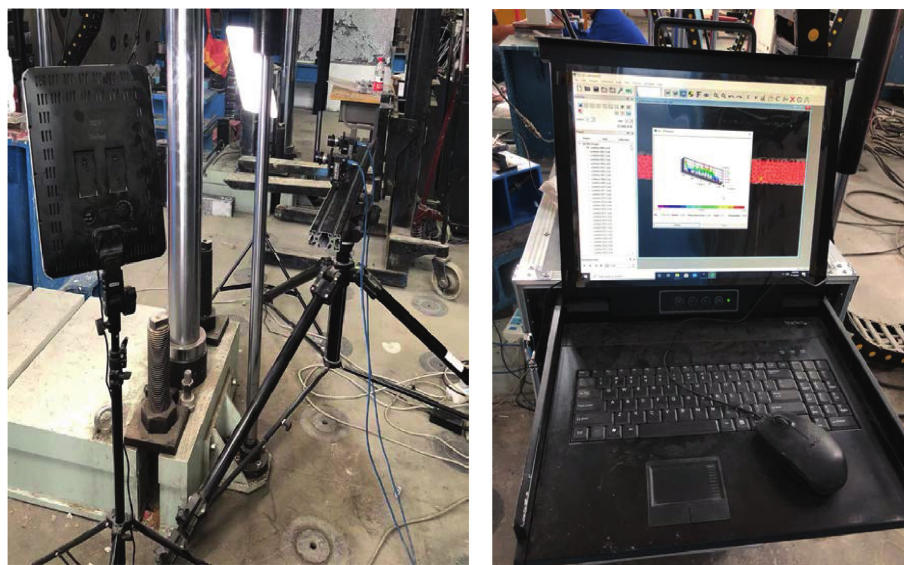
Figure 3: Test device of the DIC system.